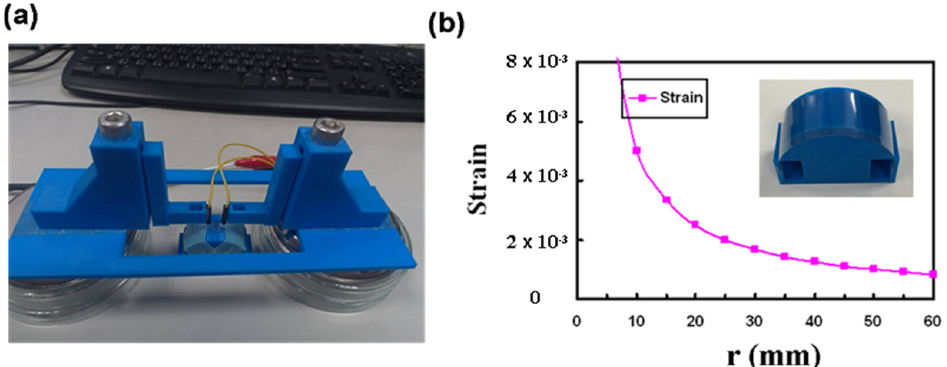
Figure 3. ( a ) Measurement setup of flexible PR strain sensors. ( b ) The relation between the applied strain ( ε ) and the arc r .